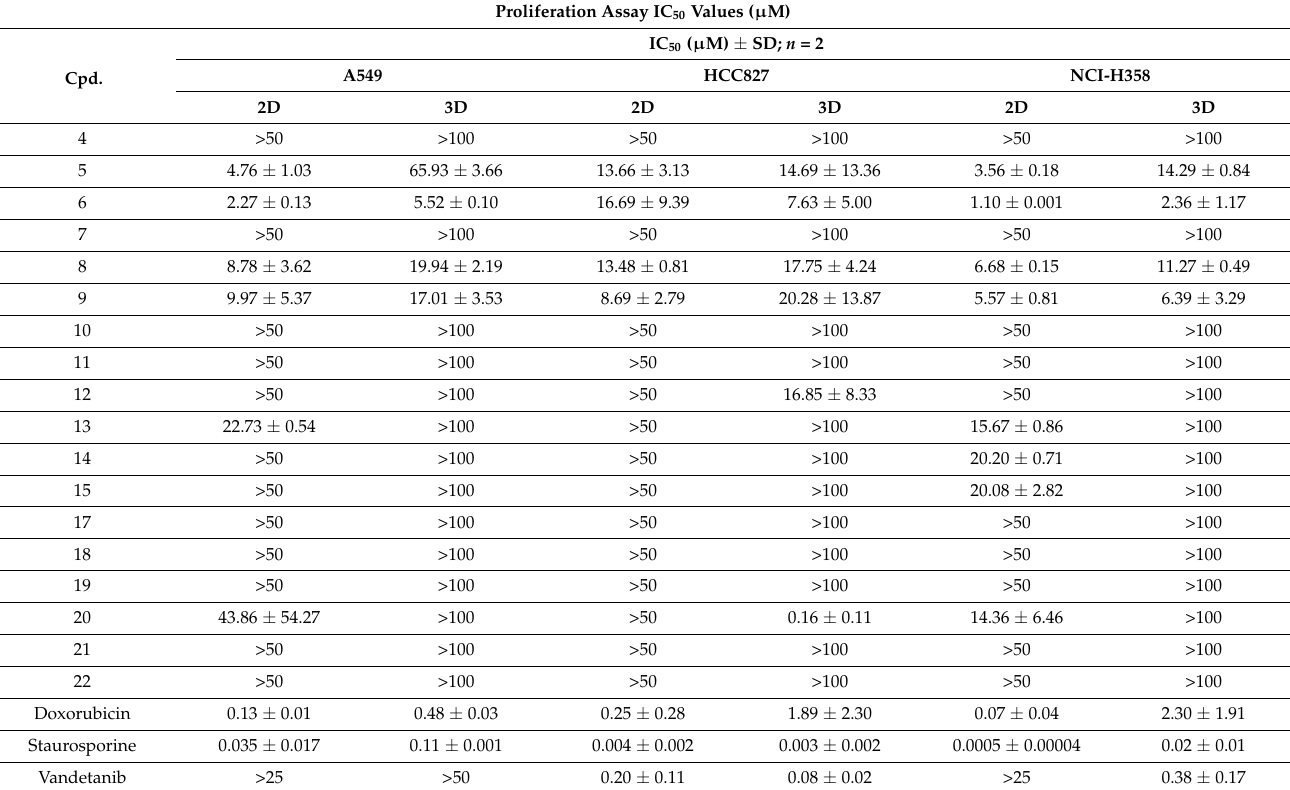
Table 2. Antiproliferation activity on 2,5-furane derivatives in 2D and 3D cell cultures. Proliferation Assay IC 50 Values ( µ M)